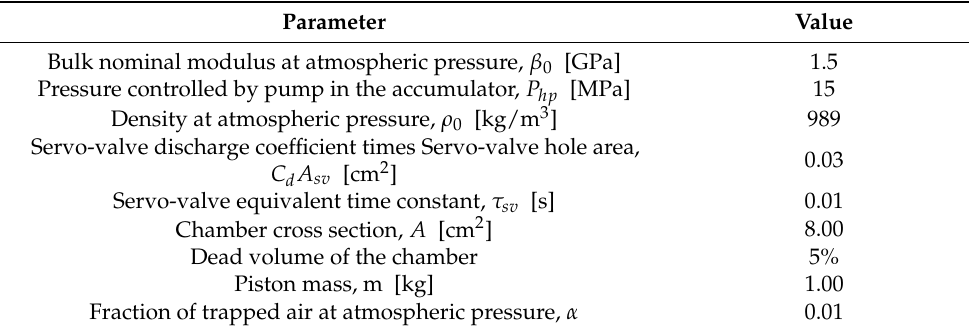
Table 1. Plant parameters. Parameter Value Bulk nominal modulus at atmospheric pressure, β 0 [GPa] 1.5